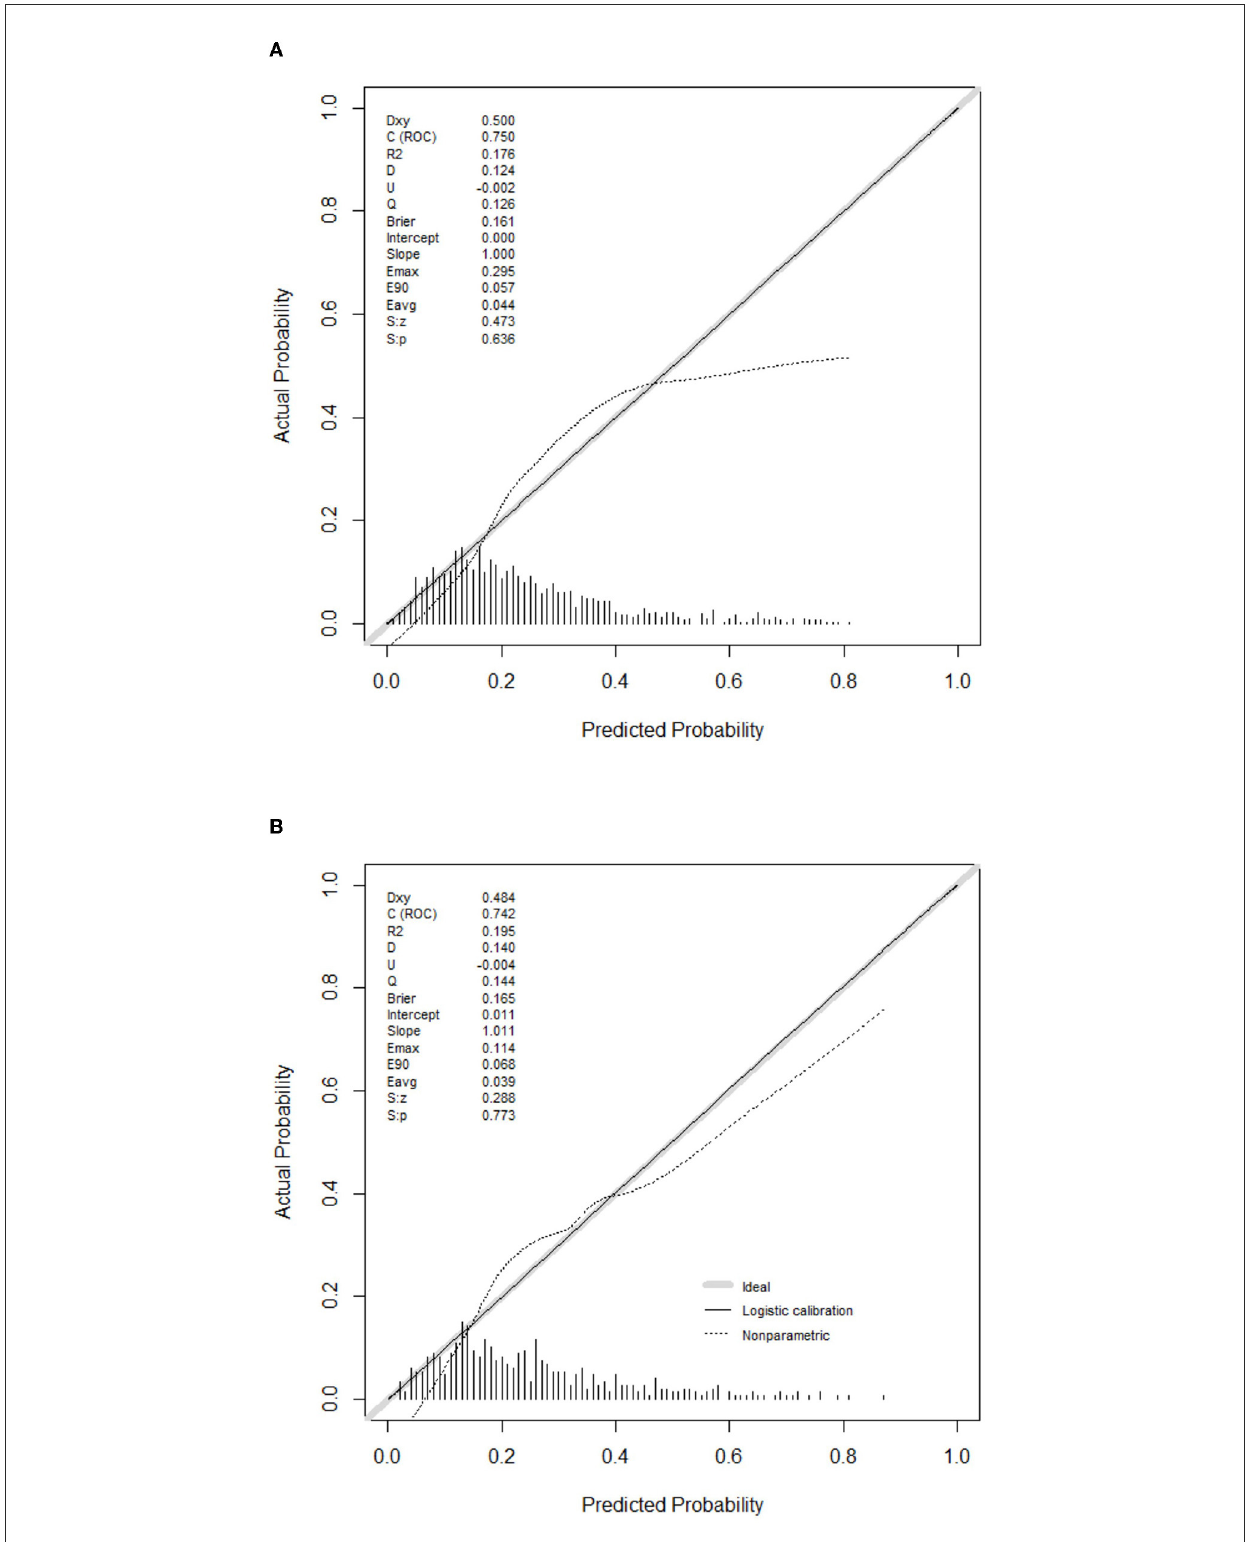
FIGURE5 Calibration curves of the model in the training (A) and validation (B)